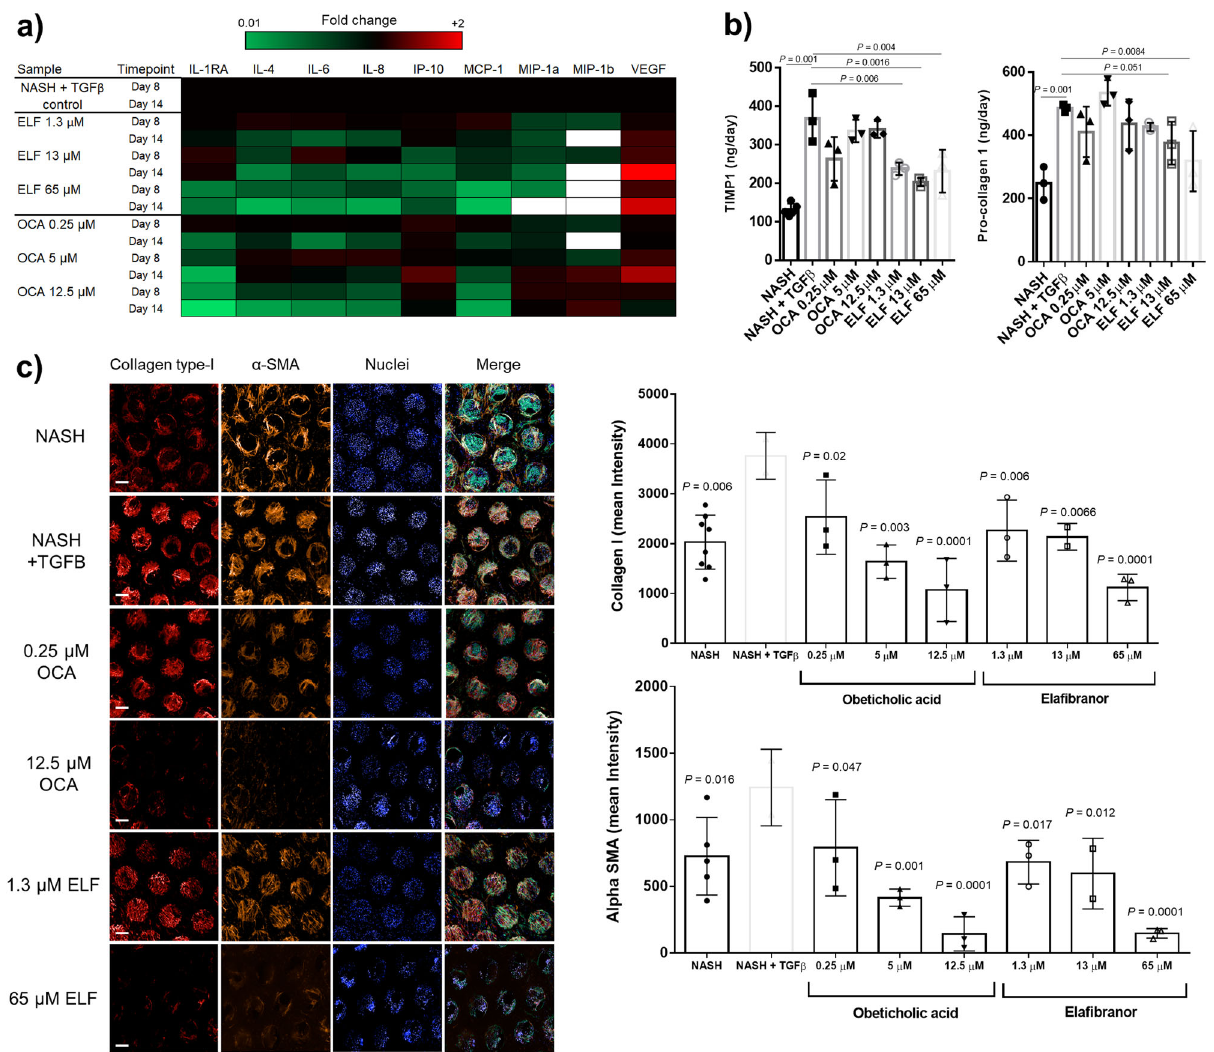
Fig. 6 Using enhanced liver MPS NASH model with TGF β , Obeticholic acid and Ela fi branor modulate disease phenotype to a greater extent than in standard NASH model. PHH, KC and HSC co-cultures were cultured in the MPS platform under high-fat conditions and dosed with varying concentrations of Obeticholic acid (OCA) and Ela fi branor (ELF) QD or vehicle control for 10 days, following an initial 4-day pre-culture phase. Throughout the compound dosing period TGF β was also dosed onto all microtissues (NASH only vehicle control samples were also included in the study for comparison, which were not treated with TGF β or dosed with any compound). a The secreted cytokine pro fi le from treated liver microtissues was compared to determine the effects of each compound on the in fl ammatory pro fi le of the liver with samples analysed at day 8 and 14 of the culture. Data were normalised by Z-transformation to allow comparison of all analytes (white = undetected). b The expression of fi brosis-associated biomarkers was analysed on day 14 media samples and compared to NASH + TGF β control samples. c Liver microtissues were stained for collagen-type I, α -SMA, nuclei (DAPI), phalloidin (green) and imaged by confocal microscopy. Representative images are shown and scale bars 200 µ m. Staining of microtissues was quanti fi ed by measuring total fl uorescence intensity throughout individual microtissues, each data point represents an average of all microtissues per MPS culture (min 8, max 20). All datapoints shown with error bars highlighting means ± SD, all data from a minimum of three independent cultures: all comparisons were made to NASH + TGF β control